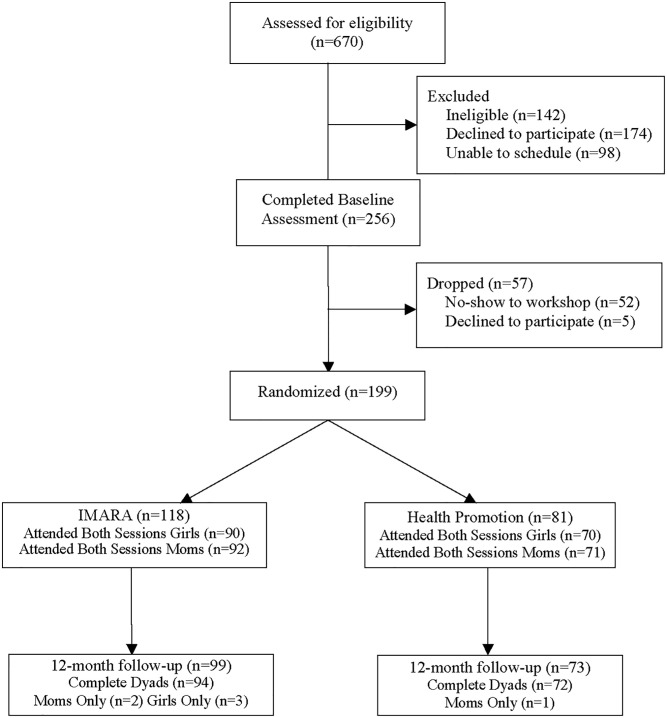
Consolidated standards of reporting trials (CONSORT) summary of participant enrollment and retention at 12-month follow-up.